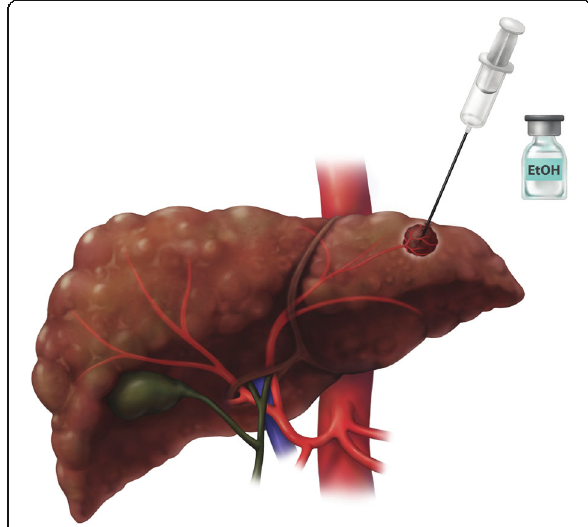
Fig. 6 Microwave ablation (MWA). Compared to radiofrequency ablation, larger tumors can be targeted in shorter treatment duration even in perivascular locations